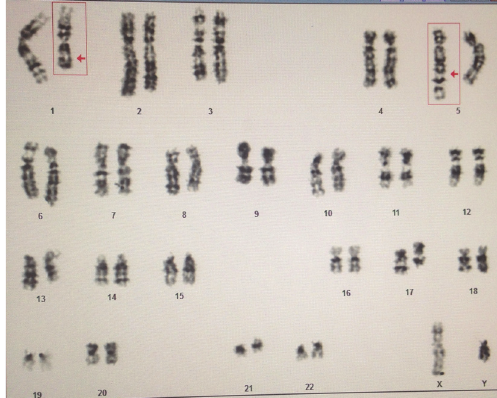
Figure 2: Karyotype analysis of the bone marrow culture revealing